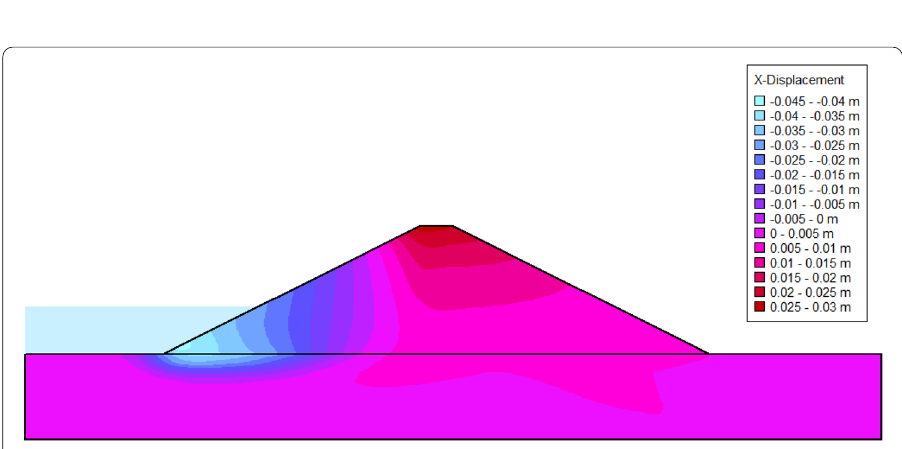
Fig. 26 Horizontal displacement contours within the earthen dam upon partial drawdown of the reservoir on the 68th